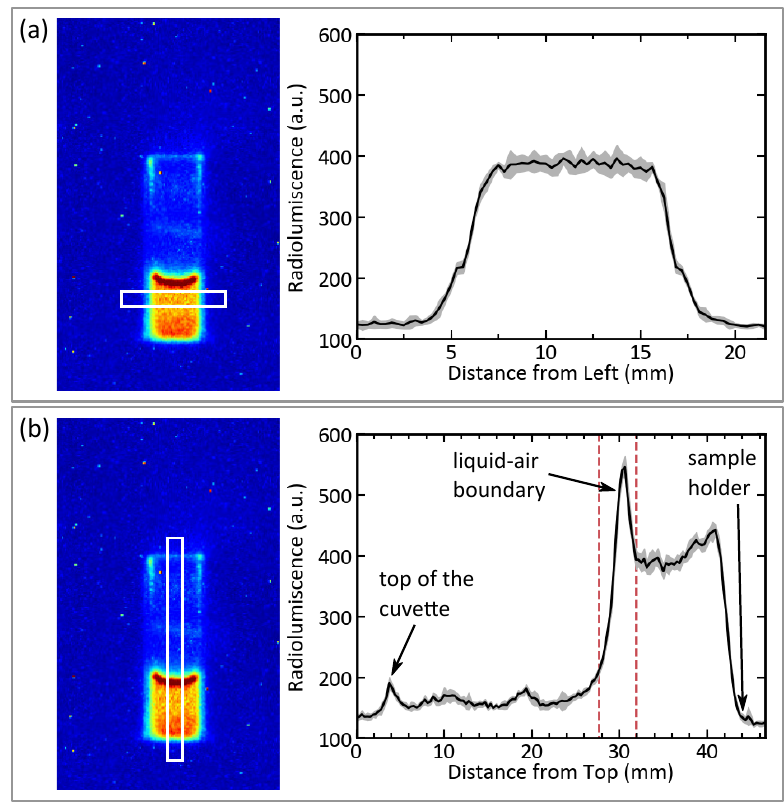
Figure 5. Cross sections of parts of the radioluminescence image of 750ppm Am-241 in 3M HNO 3 . ( a ) Horizontal cross section across the cuvette. The uncertainty displayed in gray is identical to the standard deviation of the pixel values in vertical direction. ( b ) Vertical cross section across the cuvette. The uncertainty displayed is identical to the standard deviation of the pixel values in the horizontal direction. Labels point to notable features and name the position where they